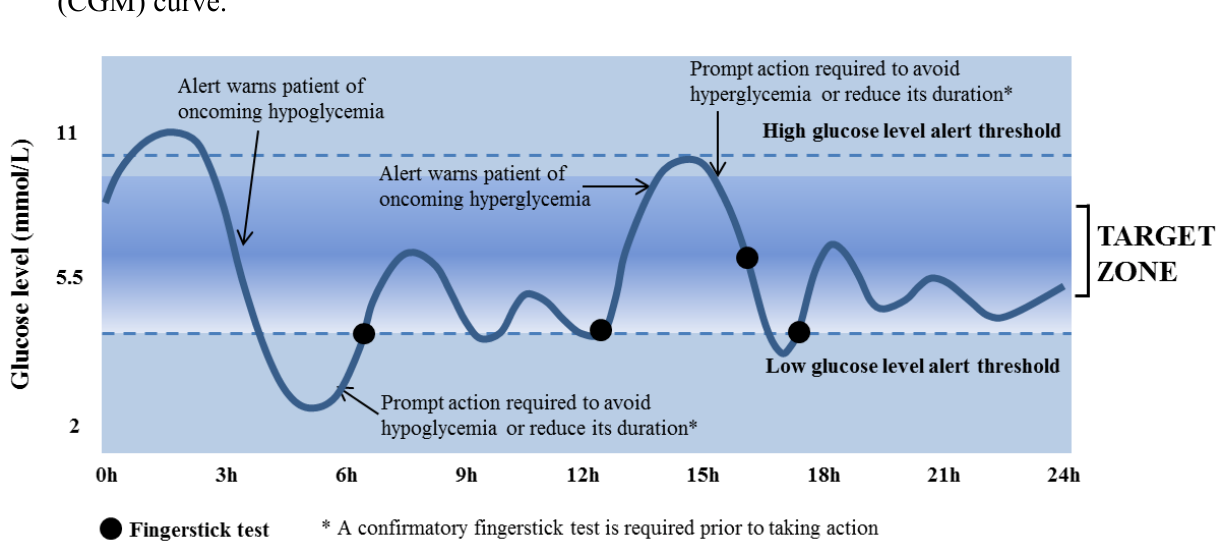
Figure 4. Visualization and interpretation of the continuous glucose monitoring (CGM)